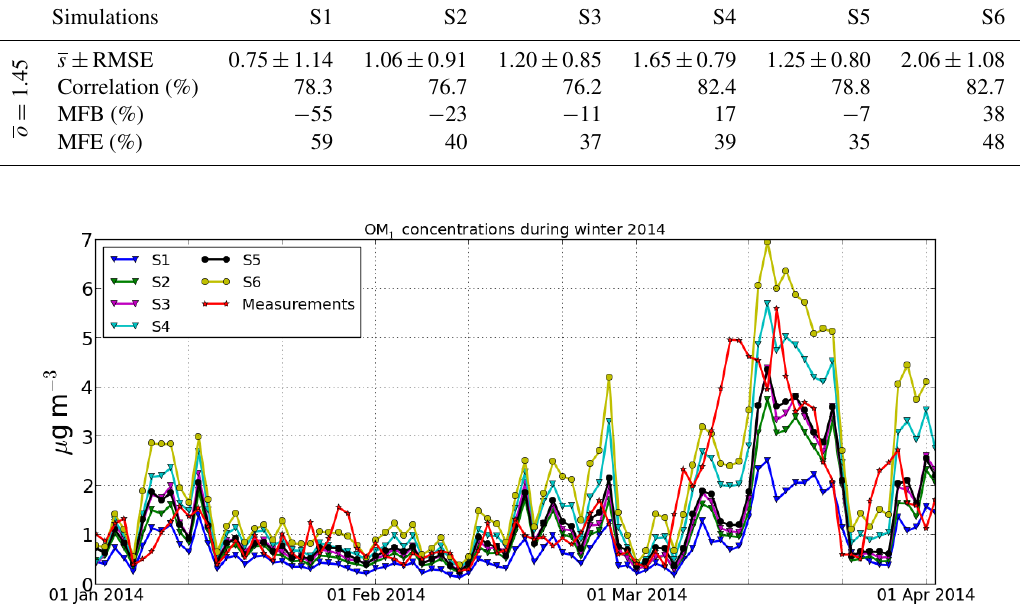
Figure 3. Daily evolution of measured and simulated OM 1 concentrations at Ersa from 1 January to 2